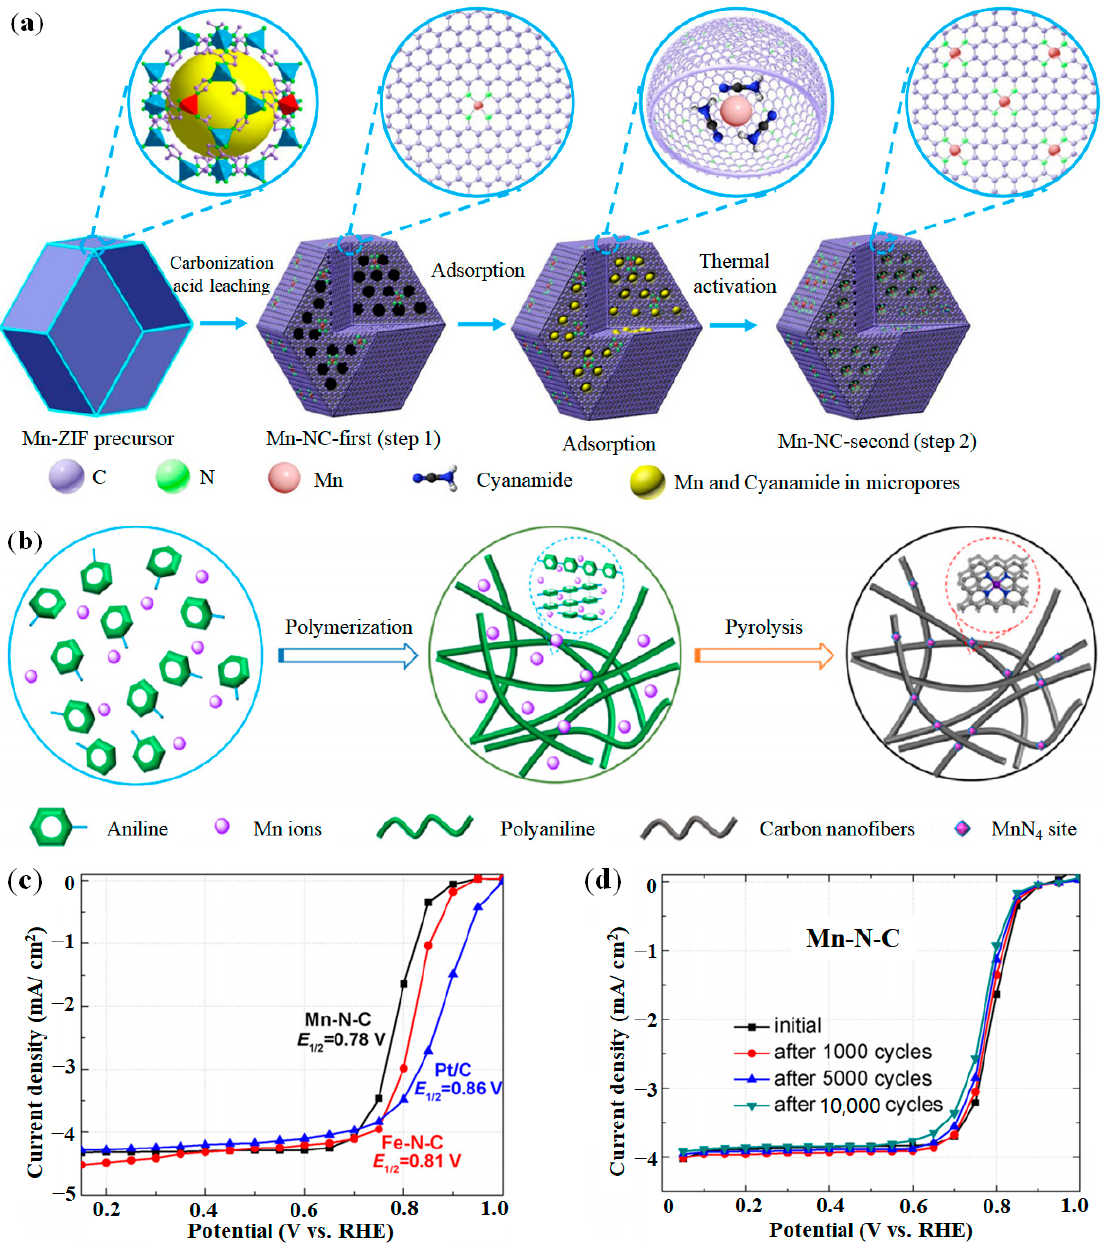
Figure 7. Synthesis methods and performance of Mn-SAC: ( a ) Synthesis strategy of Mn-NC catalyst. Adapted with permission from Ref. [90]. Copyright 2018 springer nature. ( b ) Synthesis strategy of Mn-N-C catalyst; ( c ) ORR activity; ( d ) ORR durability. Adapted with permission from Ref. [97]. Copyright 2019 Elsevier.